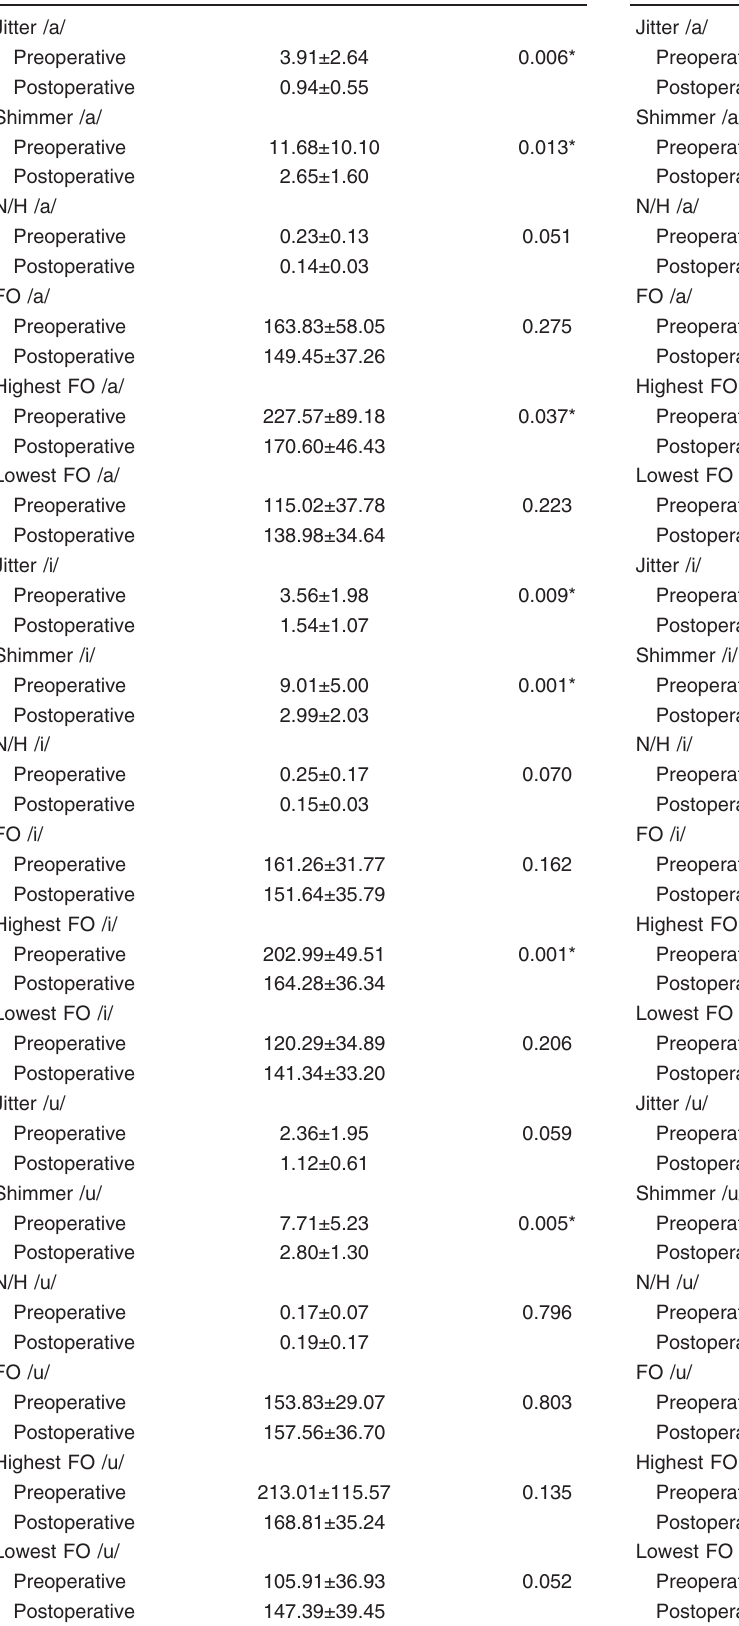
Table 10 Comparison between preoperative and postoperative data of the patients of group B